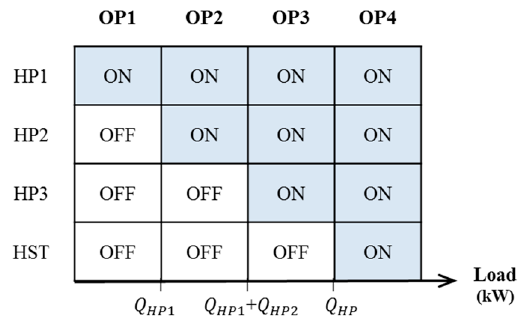
Figure 6. System operation strategy.